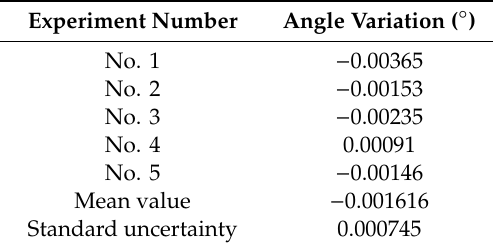
Table 6. The deflection angle from 3 × to 4 ×